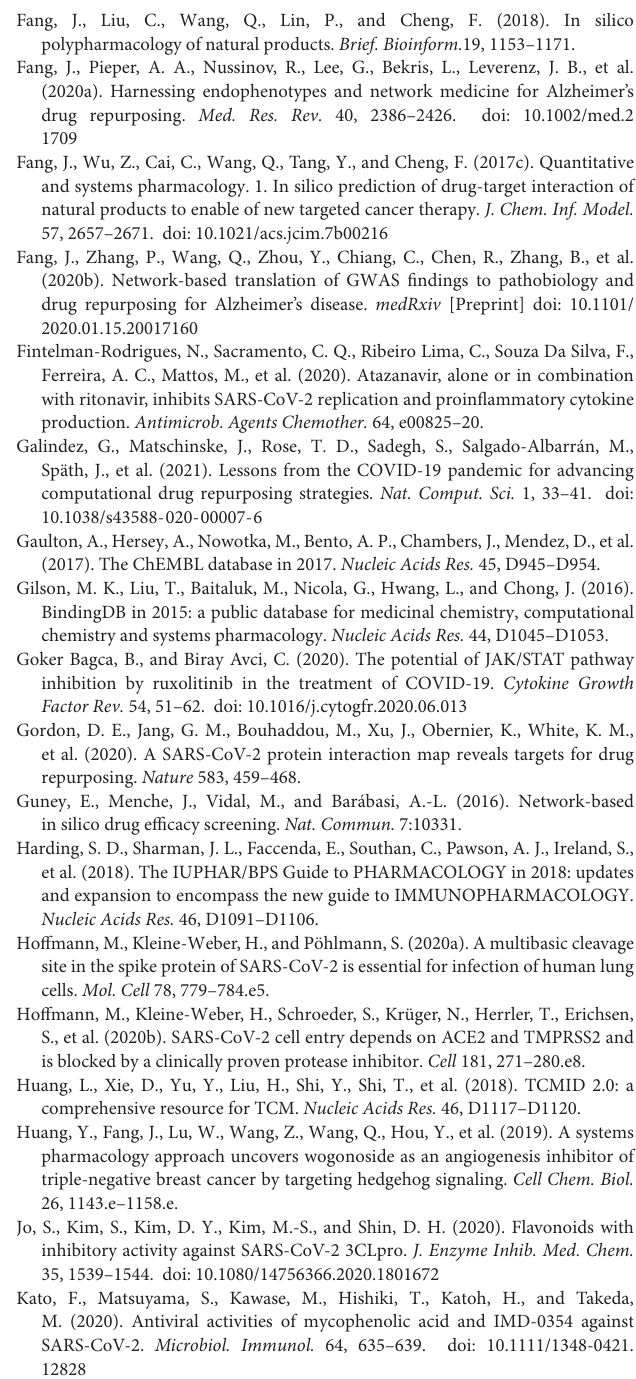
Supplementary Table 2 | Detailed information of drug-target interaction network of approved drugs and compound-protein interaction network of natural